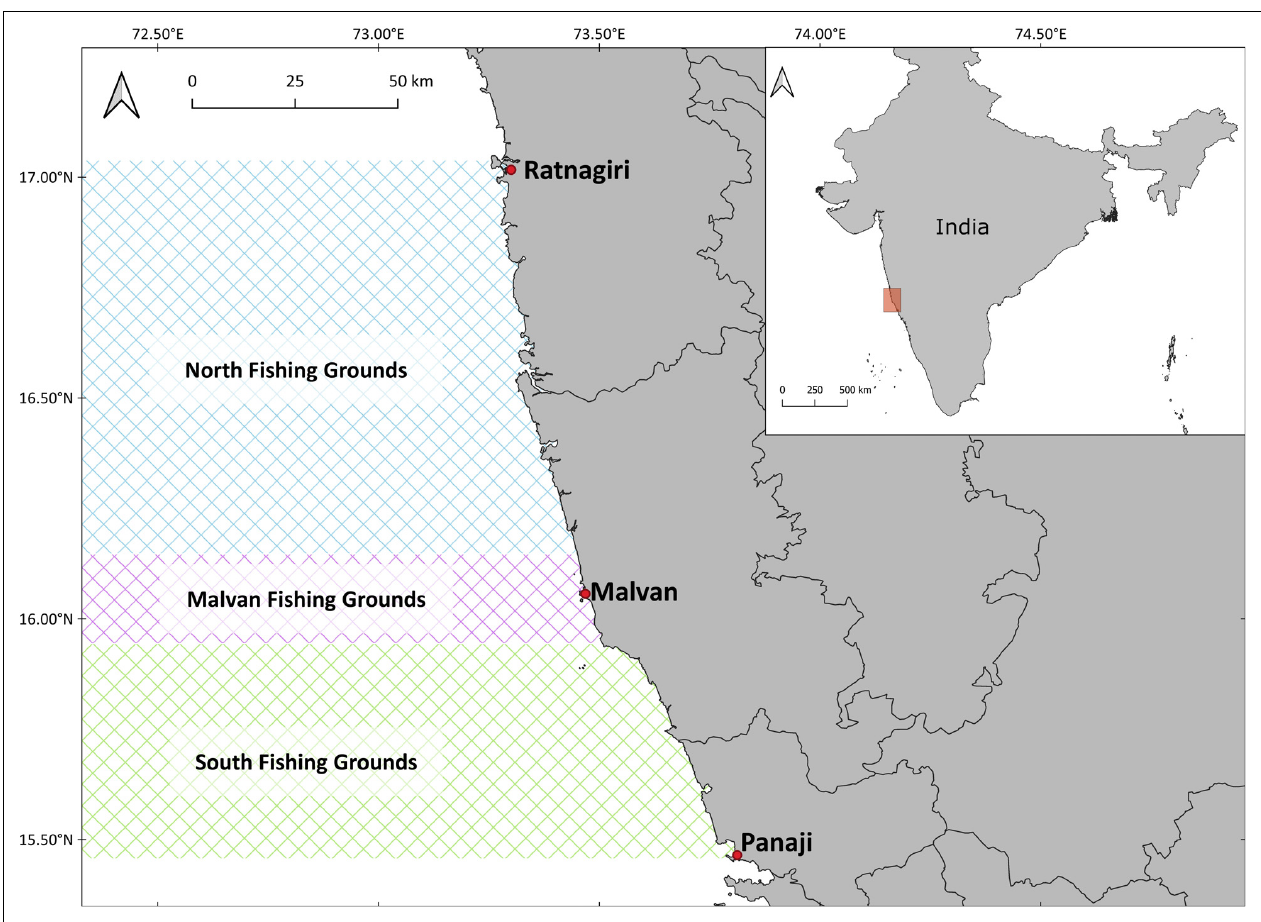
FIGURE 1 | The study site and spatial extent of the fishery, showing the different fishing grounds categorized by this study (north, Malvan, and south). The fishing grounds delimited here represent the latitudinal extend of the fishing areas only, the distances traveled offshore are unknown. Black lines in the map represent the borders of each district, while the red dots represent the main fishing towns in this